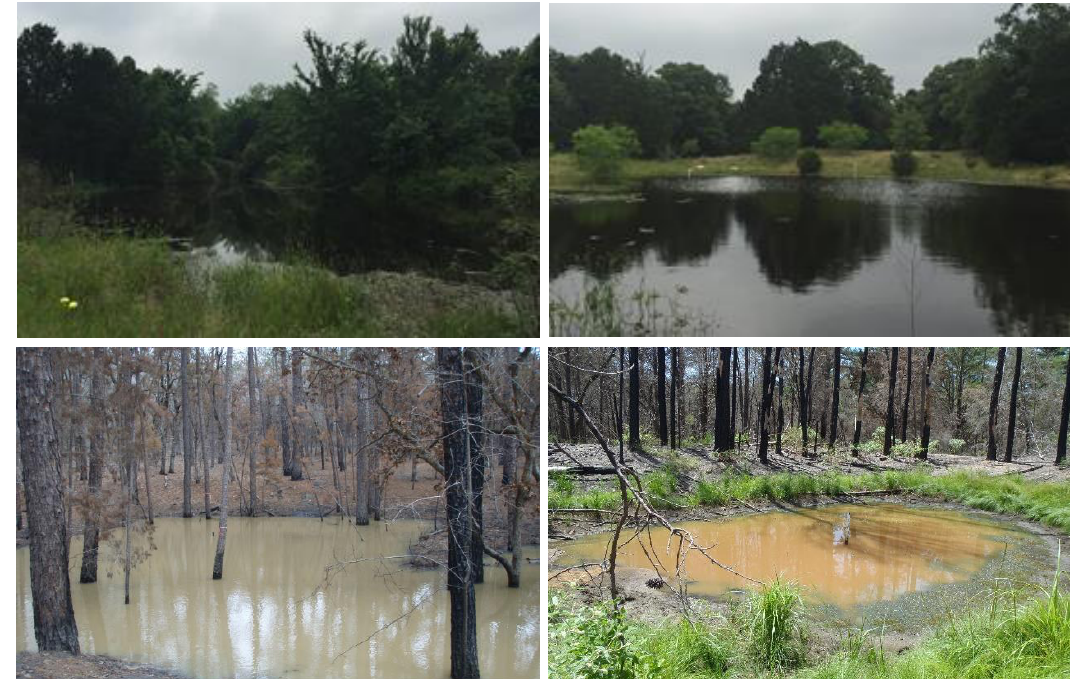
Figure 3. Ponds sampled on the Griffith League Ranch in Bastrop County, Texas. Ponds 1 ( top left ) and 5 ( top right ) are located in the unburned areas (photos by Andrea Villamizar-Gomez and Ivana Mali). Ponds 13 ( bottom left ) and 14 ( bottom right ) are located in the burned areas (photos by Donald J. Brown and Ivana